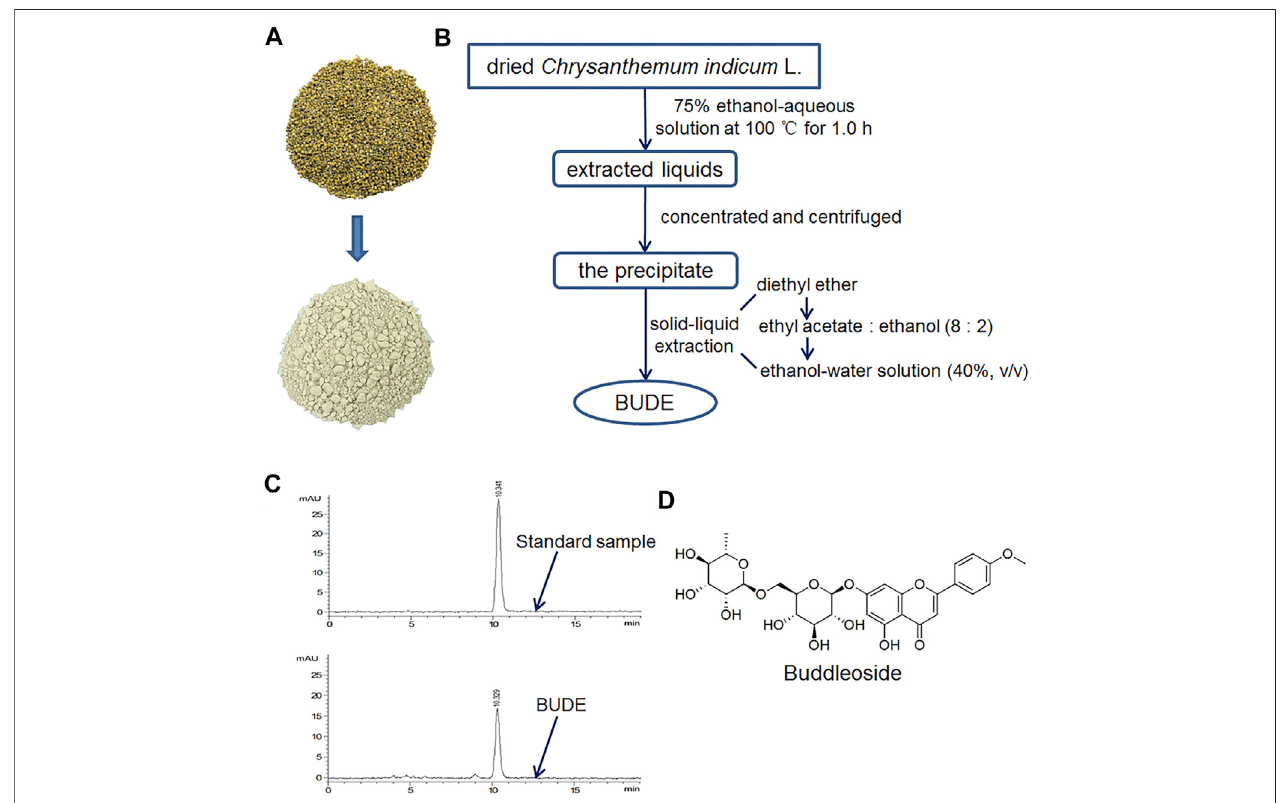
FIGURE 1 | Characteristics and extraction fl ow chart of buddleoside-rich Chrysanthemum indicum L. extract (BUDE). (A) The representative photos of Chrysanthemum indicum L. and BUDE. (B) Extraction fl owchart of BUDE (C) HPLC chromatograms of buddleoside (BUD) and BUDE. (D) The chemical structure of BUD.